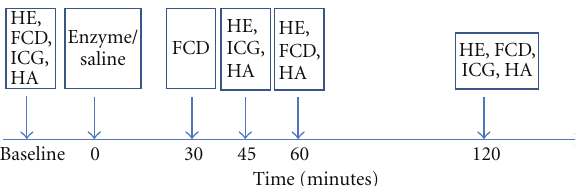
Figure 1: The time line shows the experimental setup. Baseline reg- istrations includes hemodynamic and hematologic data (HE), func- tional capillary density (FCD) the distribution volume of indocya- nine green (ICG) and plasma hyaluronan (HA). Enzyme or saline was given at time zero. Following measurements are indicated with an arrow.